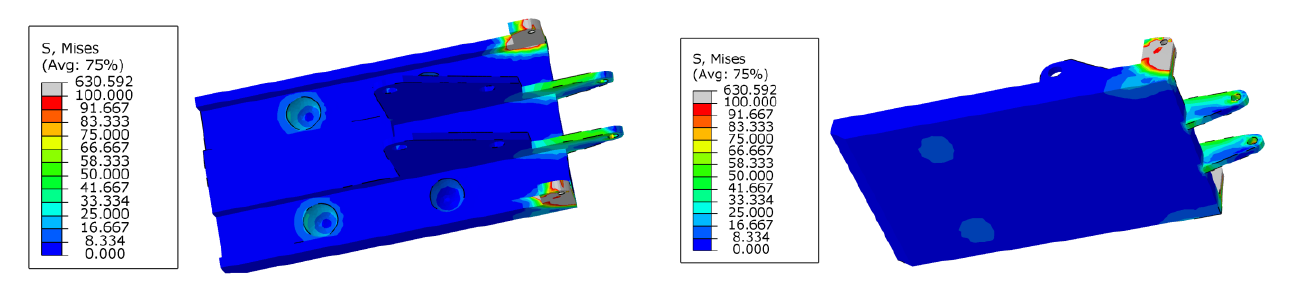
Figure 13. Stress of rear top beam.